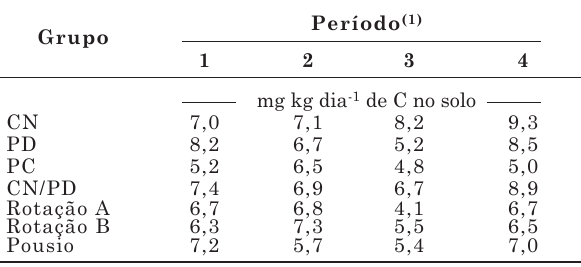
Quadro 5. Médias dos grupos avaliados nos contras- tes ortogonais para taxa de atividade respira- tória da microbiota do solo Período Grupo